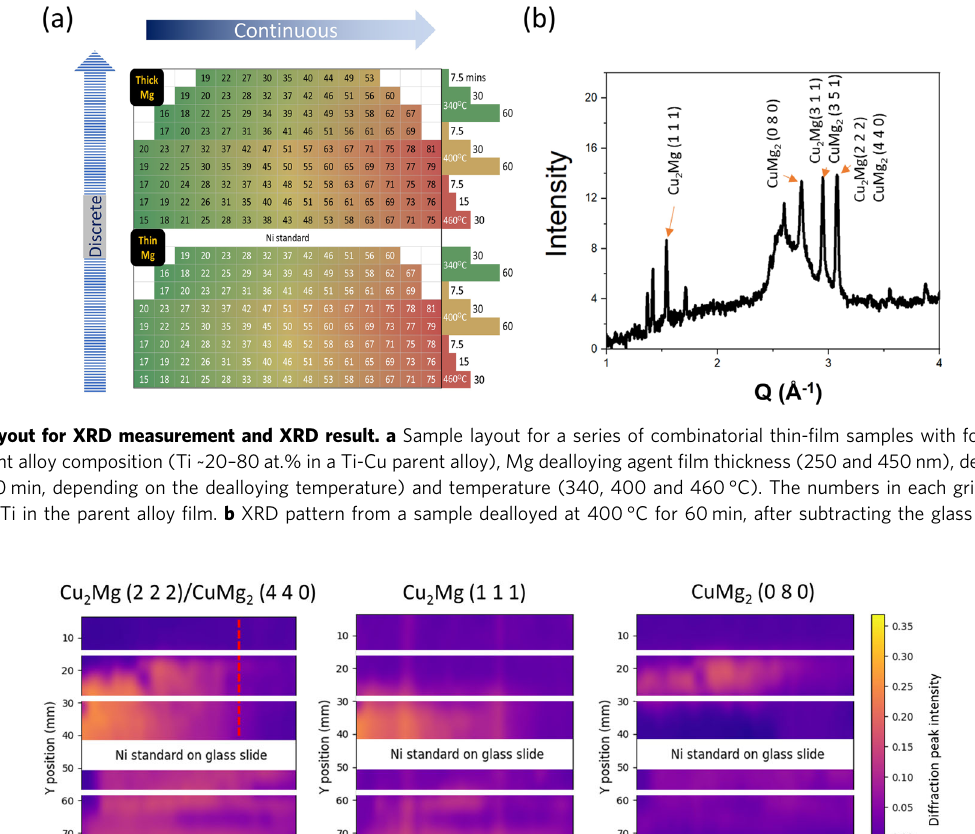
be discussed in the next section.